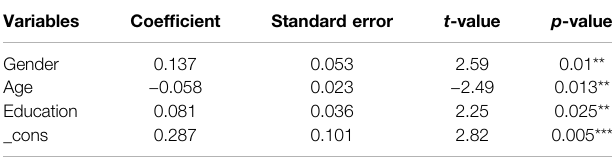
TABLE 2 | Estimates of probit model: awareness of water quality.